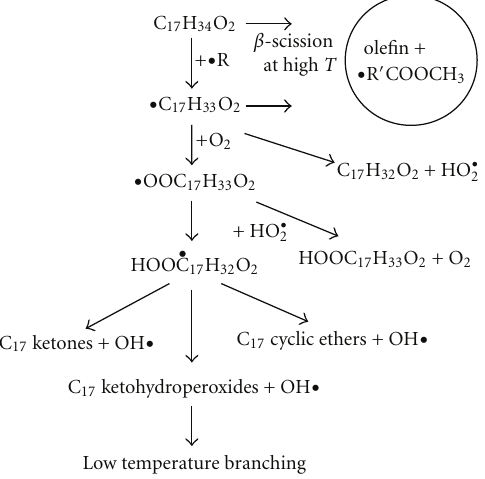
Figure 2: The skeletal reaction pathways for the oxidation of